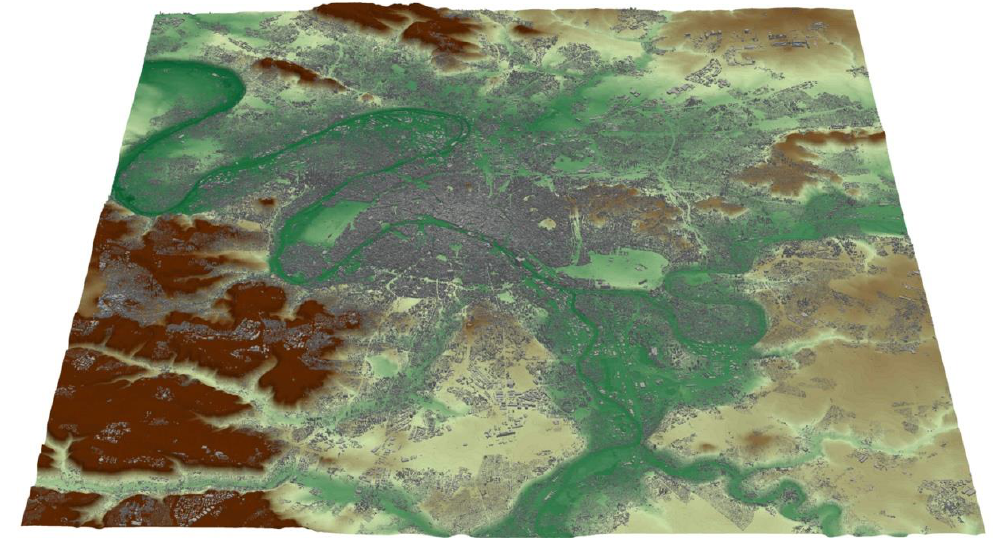
Figure 1. 3D view of the topography and buildings. North is at the top. The domain contained three very high-resolution nested domains around specific buildings, a museum, a train station, and an administrative building, with 1-m grid